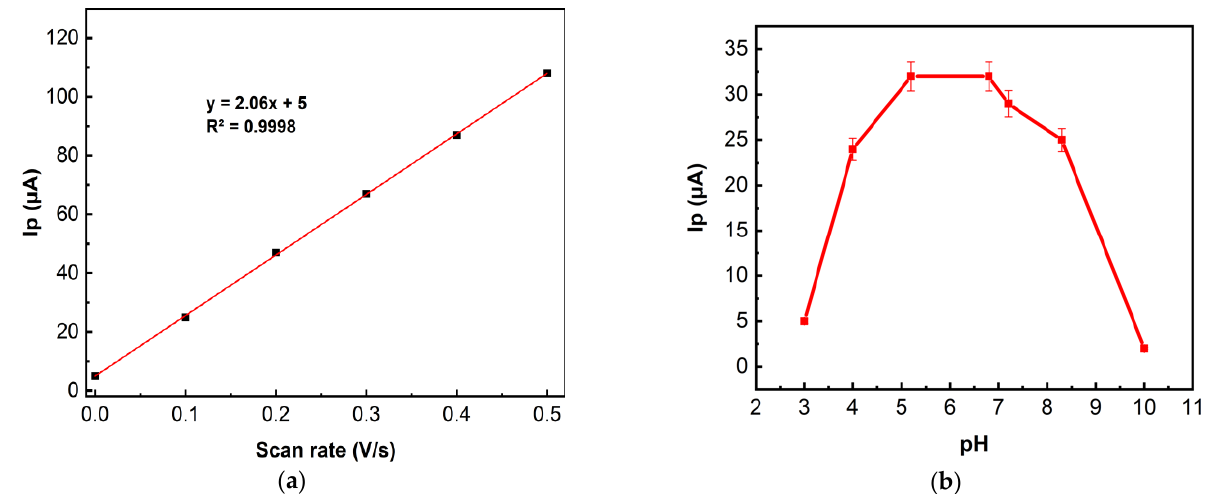
Figure 6. ( a ) The dependence of the carbaryl (15 mg/L in 96% ethanol and deionized water (1:1)) CV anodic peak currents in BR buffer solution (7.00 pH) on the scan rate (0.1 V/s to 0.5 V/s); ( b ) Influence of pH on the LSV anodic peak current of carbaryl (15 mg/L in 96% ethanol and deionized water (1:1)) on the LRGO grid electrode in BR buffers of different pH values; scan rate of 300 mV/s. n = 3